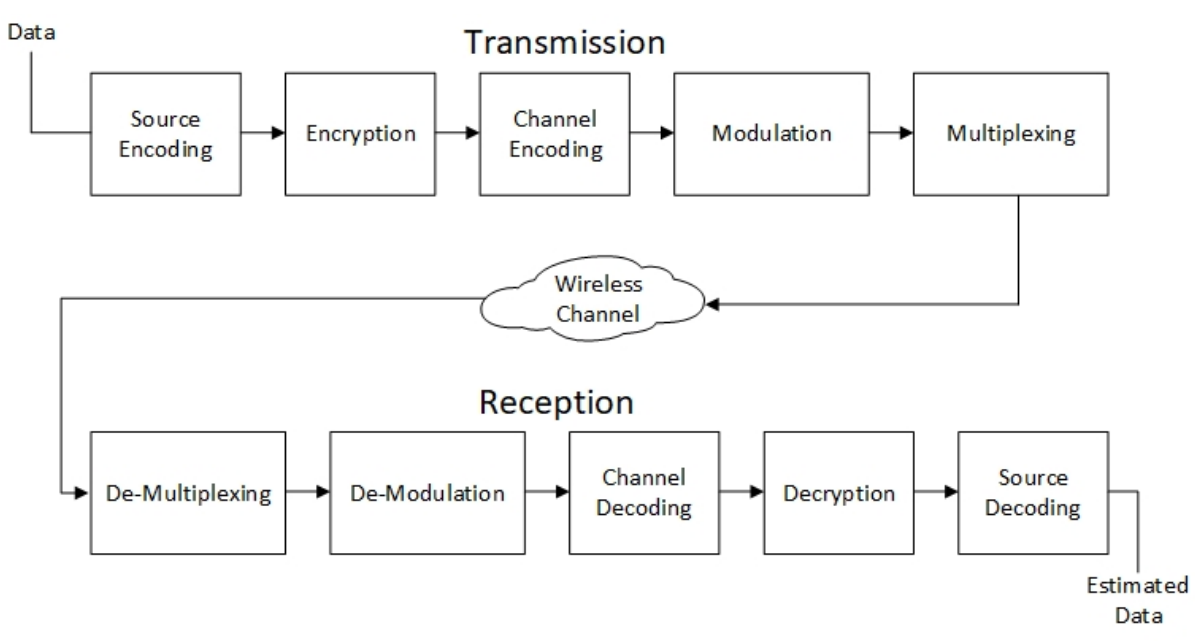
Figure 1. Basic diagram of wireless communication [1].